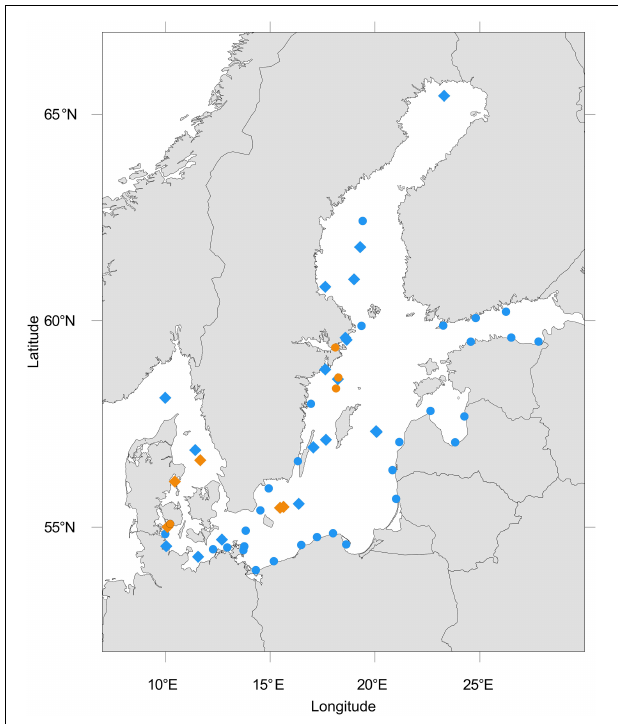
FIGURE 1 | Location of analyzed Baltic Sea metagenomes downloaded from NCBI. The blue color represents metagenomes from the water column and orange represents those from sediments. Dots represent single metagenomes, diamond shapes represent a depth profile of sediment or water metagenomes, or time-series samples. Some metagenomes were sampled in close proximity to another such that overlaying symbols may entail more than one